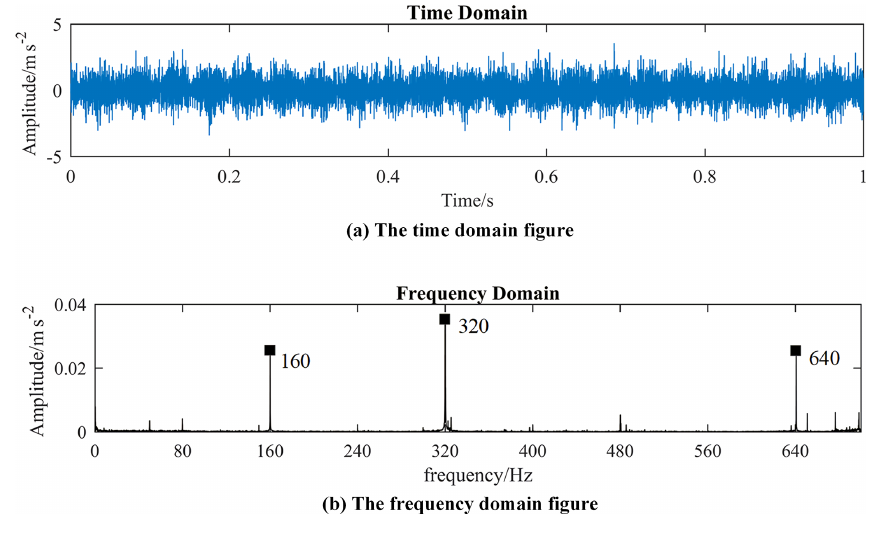
Figure 18. Vibration signal of the motorized spindle at 4800rpm.